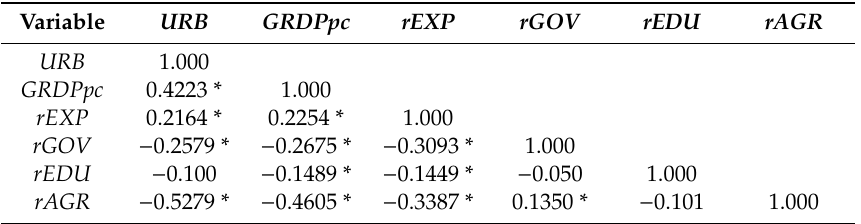
Table 3. Correlation matrix.